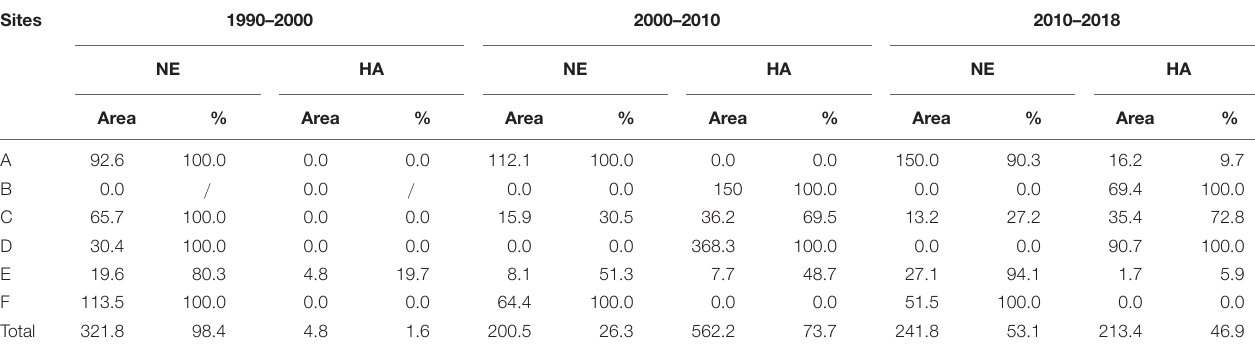
TABLE 4 | Areas (ha) and proportion (%) of mangrove forest in newly gained (restored) mangrove during studied periods in sites